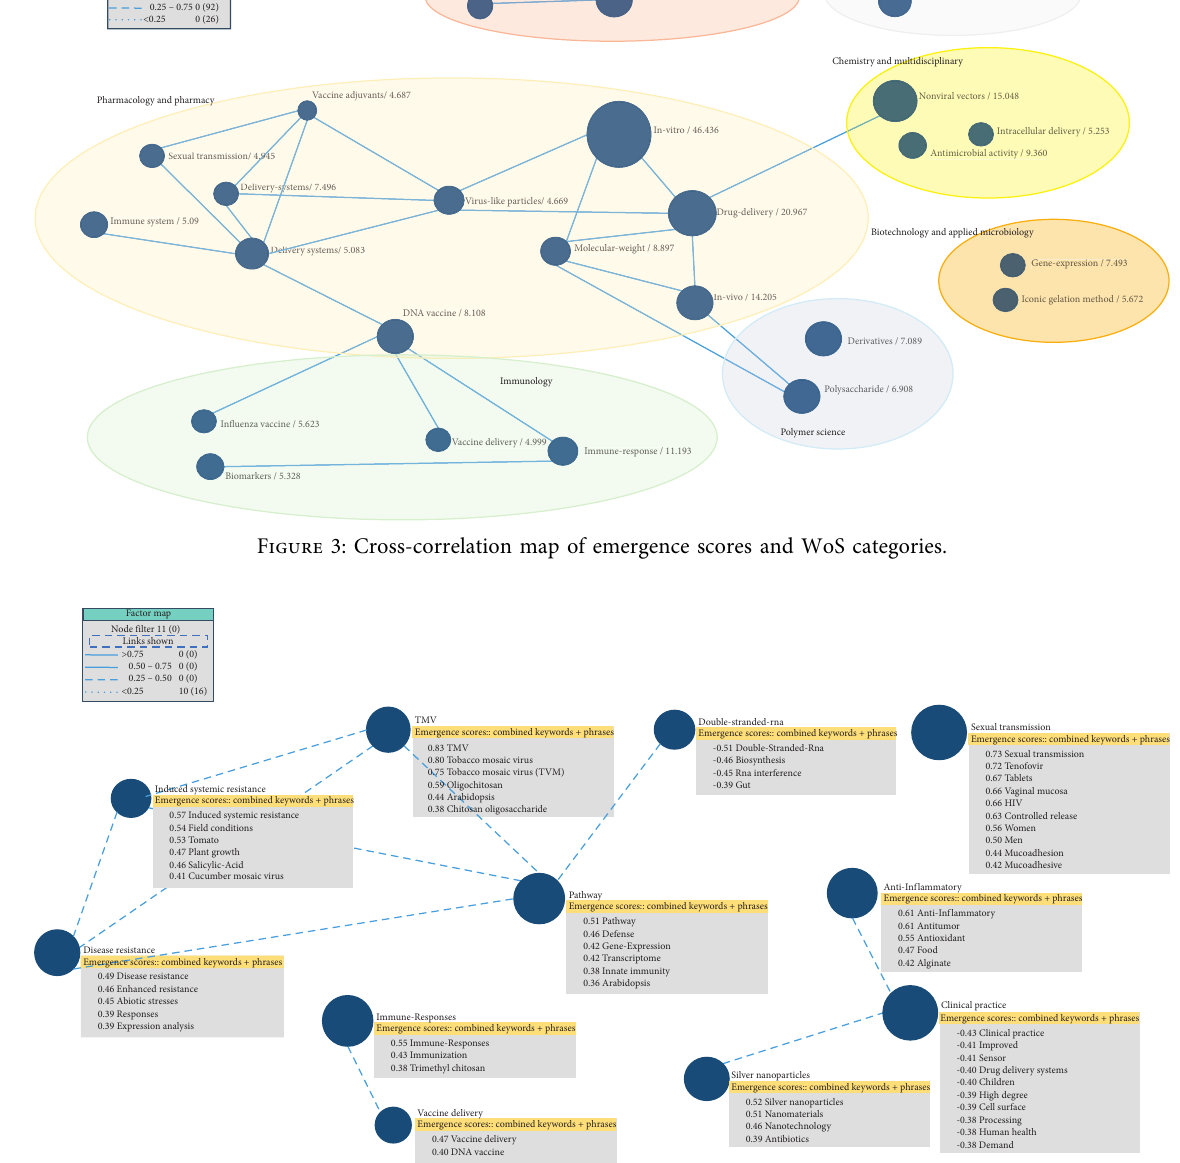
Figure 4: Factor map of emergence